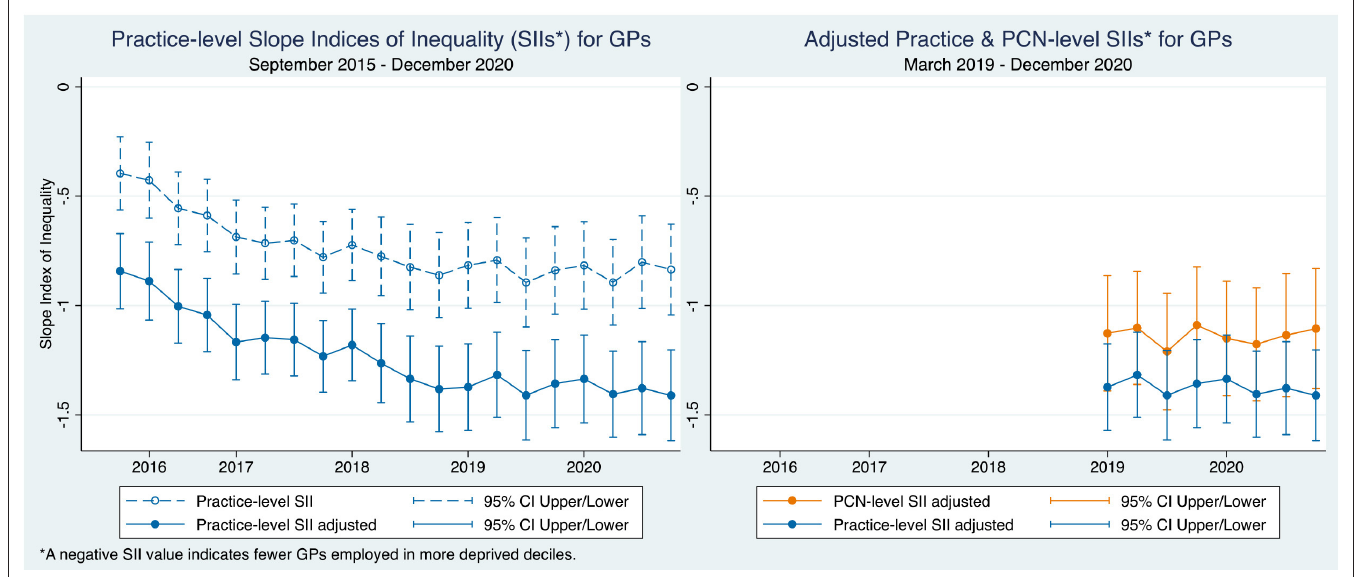
Figure 1 Practice and PCN- level slope indices of inequality (SIIs) over time for GPs. PCN = primary care